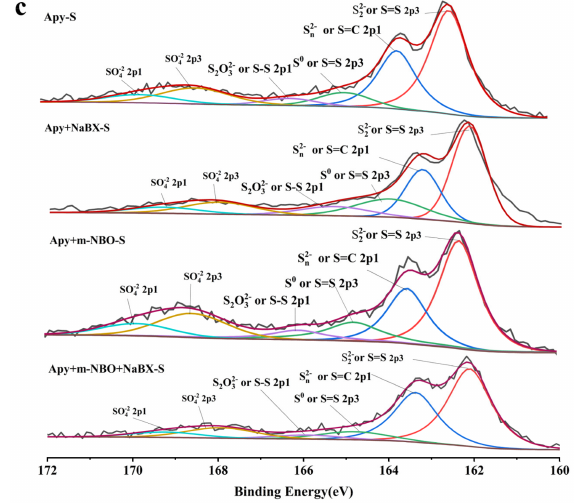
Figure 7. XPS of arsenopyrite after interactions with m-NBO and NaBX; pH = 11.5, C (m-NBO) = 50 mg · L − 1 , C (NaBX) = 1.6 × 10 − 3 mol · L − 1 ; ( a ) Fe 2p, ( b ) As 3d, ( c ) S 2p. As shown in Figure 7a, most of the iron atoms on the surface of arsenopyrite are Fe(II) combined with As–S ion groups. As Fe(II) has almost the same binding energy when combined with As–S or S–S [36], the content of Fe(II)–AsS is used to express the total Fe(II)-As and Fe(II)–S contents. For accurate comparison of the relative species distribution changes before and after the action of arsenopyrite with m-NBO and NaBX, the same full width at half maximum was set under the same binding energy or the corresponding chemical state, as shown in Table 3. Table 3. Distribution of the chemical state, binding energy, and atomic concentration of the surface elements Fe 2p, As 2p, and S 3d before and after the adsorption of m-NBO and NaBX on arsenopyrite. FWHW, full width at half maximum.